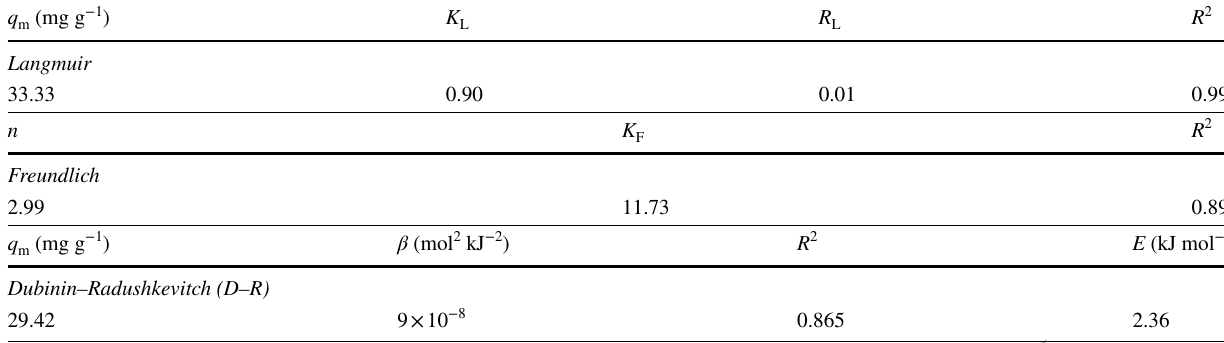
Table 3 Langmuir, Freundlich and D–R isotherm constants for the adsorption of As(III) onto the used cigarette filter